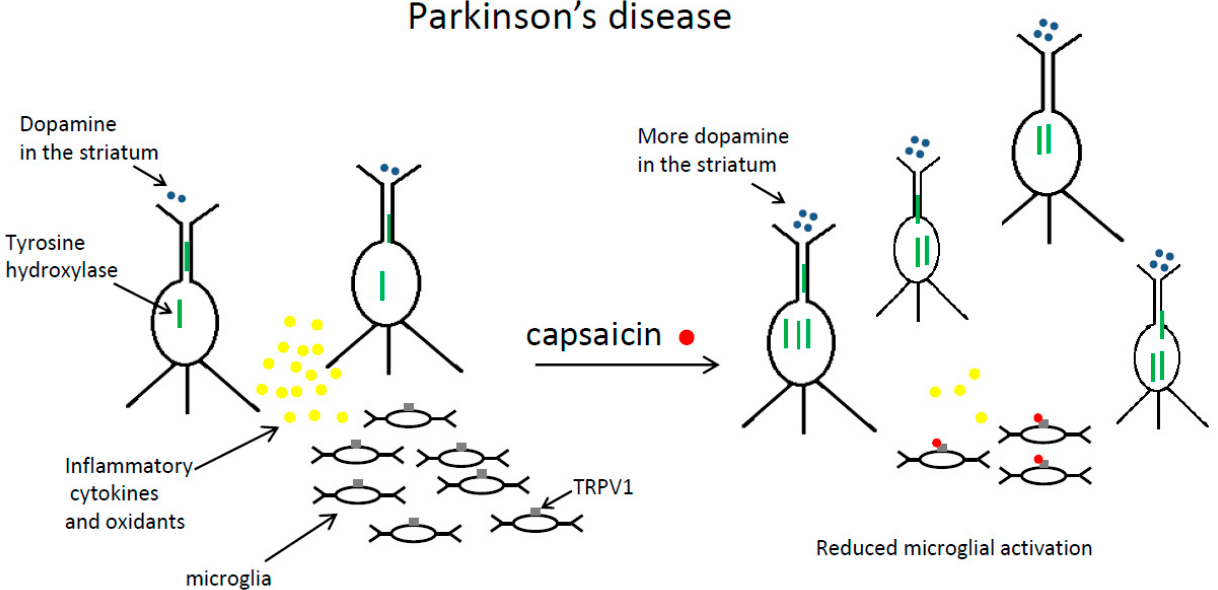
Figure 3. The beneficial effects of capsaicin in Parkinson’s disease are shown in simplified form. Capsaicin administration increases the number of dopaminergic neurons in the substantia nigra and the expression of tyrosine hydroxylase in these neurons. Consequently, there is more dopamine in the striatum. Moreover, after capsaicin treatment, microglial cells in the substantia nigra produce fewer oxidants and inflammatory cytokines. Left panel—before capsaicin treatment, right panel—after capsaicin